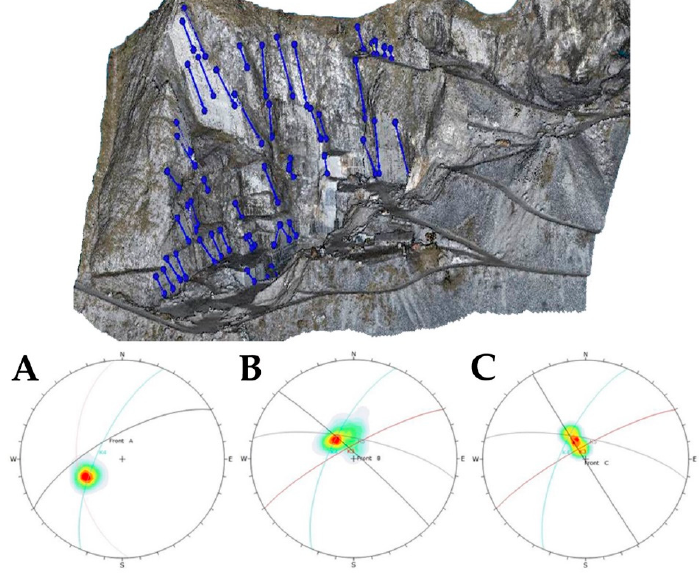
Figure 13. Traces identification (blue lines) on the portion of point cloud of the entire quarry representing excavation faces A, B and C and obtained stereonets.